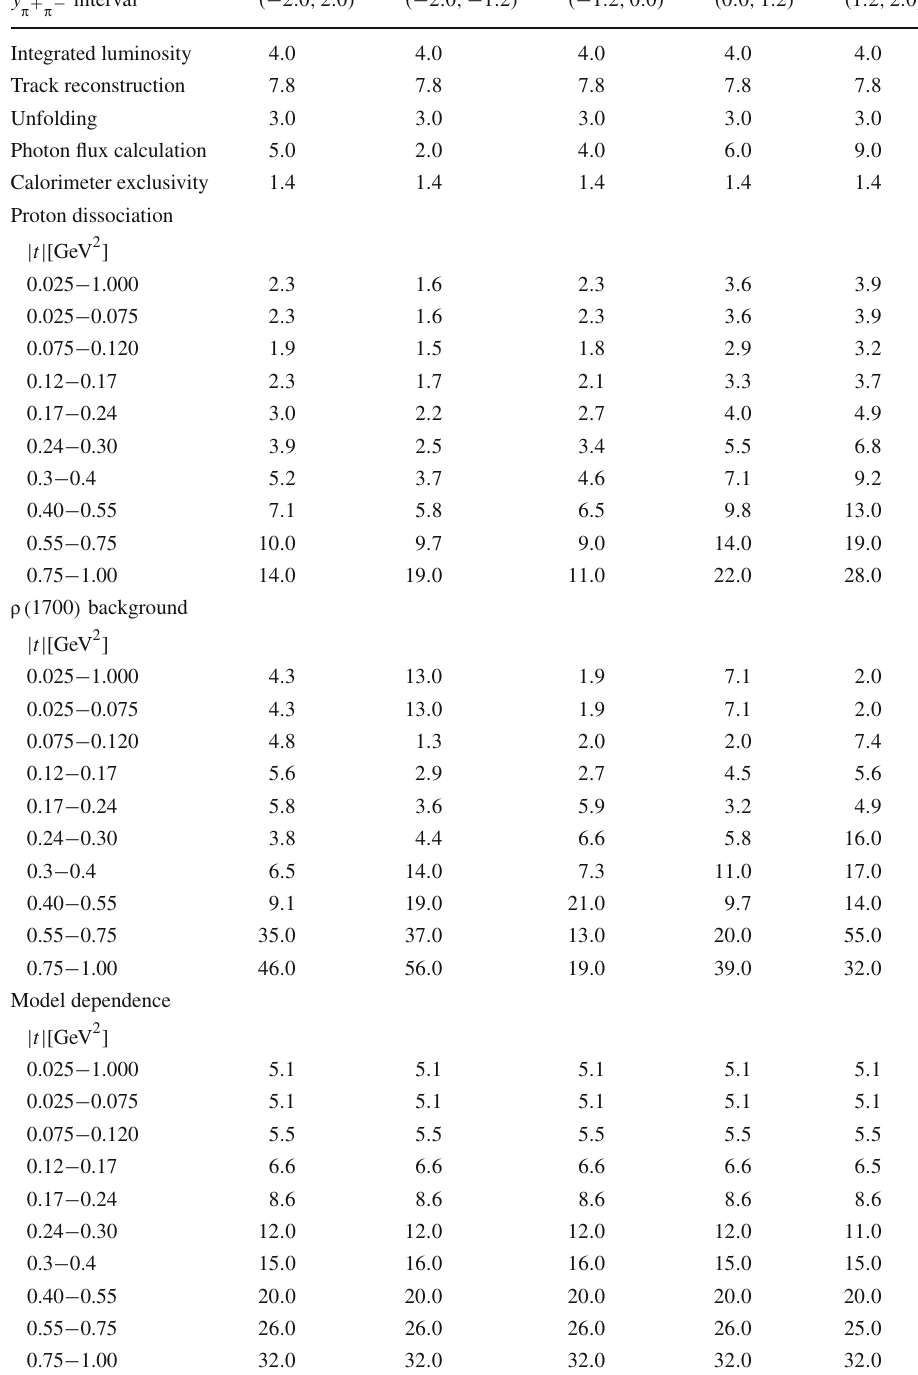
systematic uncertainties in the ρ ( 770 ) 0 photoproduction cross section. The numbers are given in percent. The total uncertainty is calculated by adding the individual uncertainties in